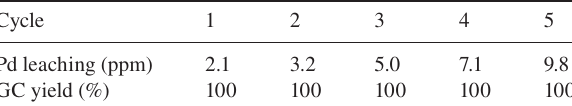
Table 2 Catalyst leaching and product yield at different